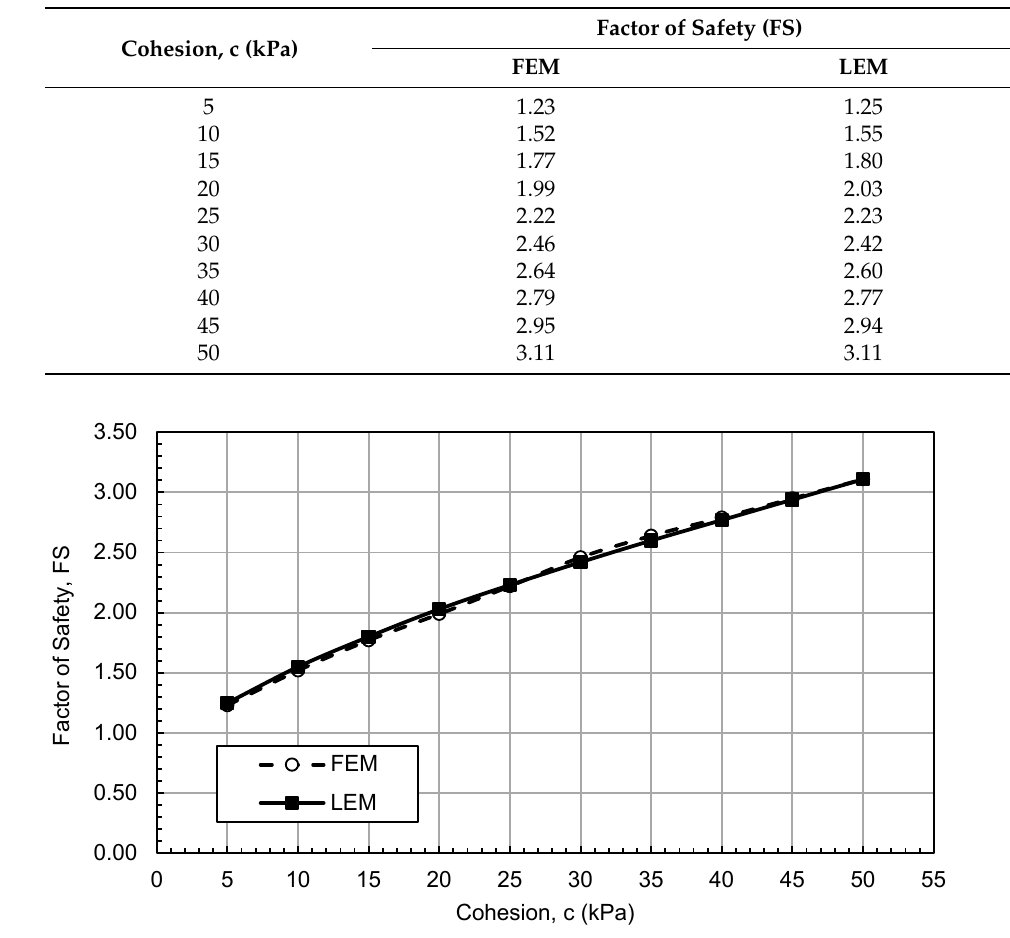
Figure 4. Variation in FS with c.